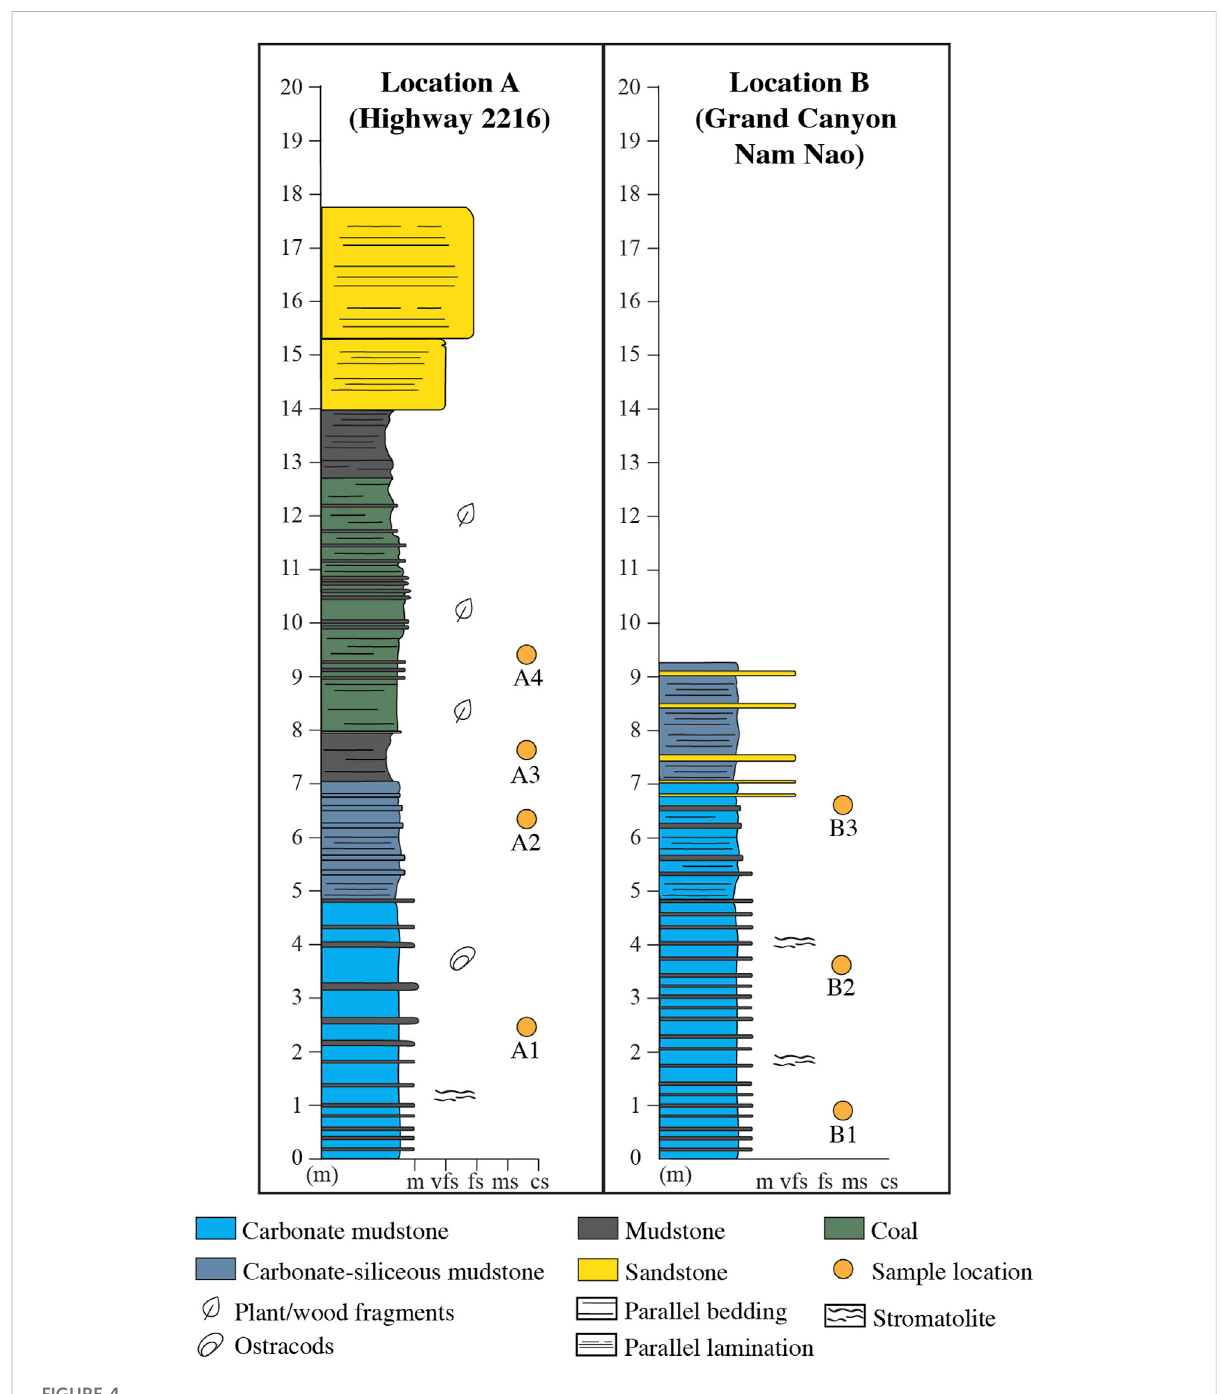
FIGURE 4 Detailed stratigraphic column of the Huai Hin Lat outcrops from locations A and